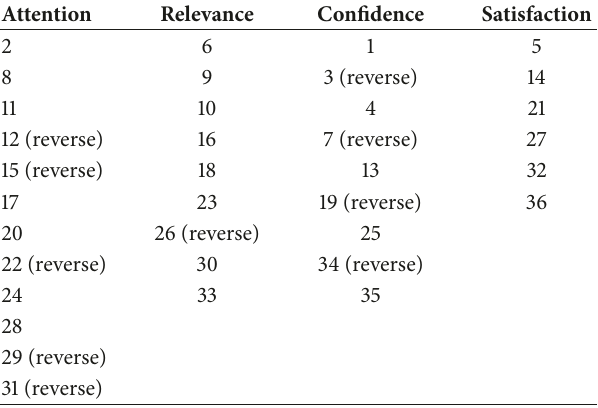
Table 6: IMMS reliability estimates [17]. Scale Reliability estimate (Cronbach 𝛼 ) Attention 0.89 Relevance 0.81 Confidence 0.90 Satisfaction 0.92 Total